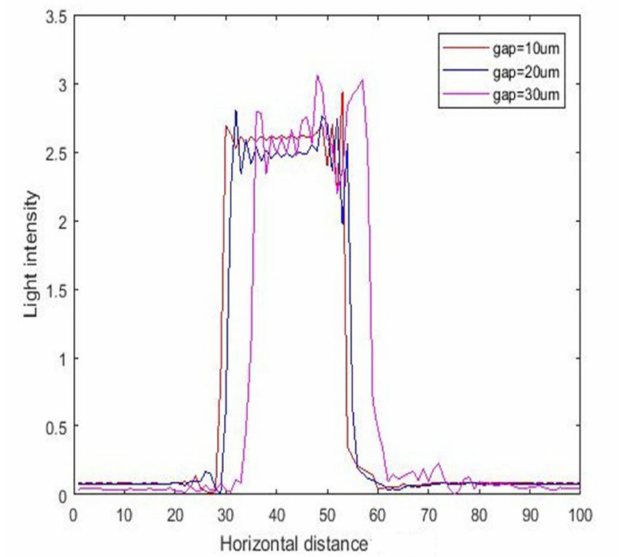
Figure 11. The intensity curve for inclined exposure with di ff erent air gaps (10, 20, and 30 µ m) at 23.5 ◦